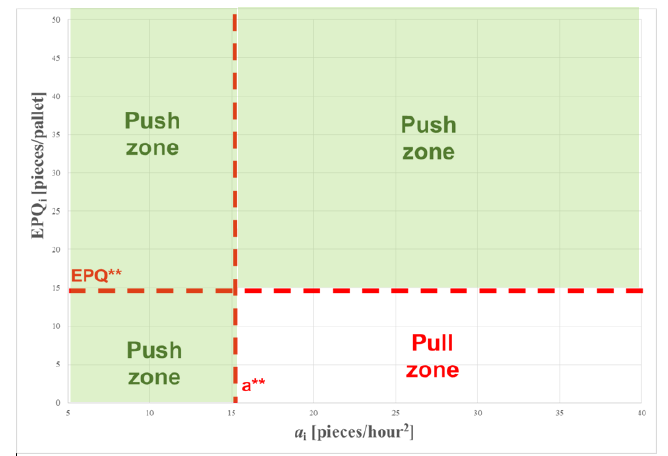
Figure 5. Final optimal PUSH/PULL policy definition for different parts i.